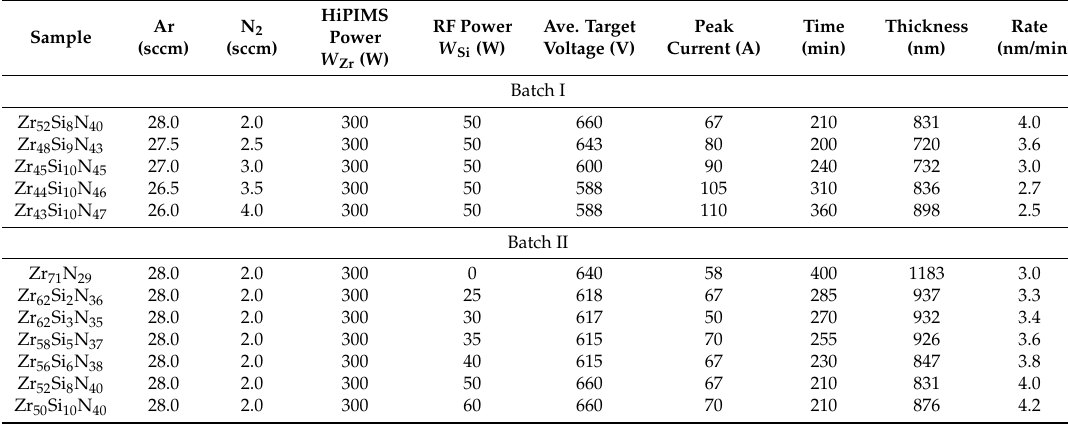
Table 2. Chemical compositions, surface roughness, mechanical properties and residual stress values of Zr–Si–N films.